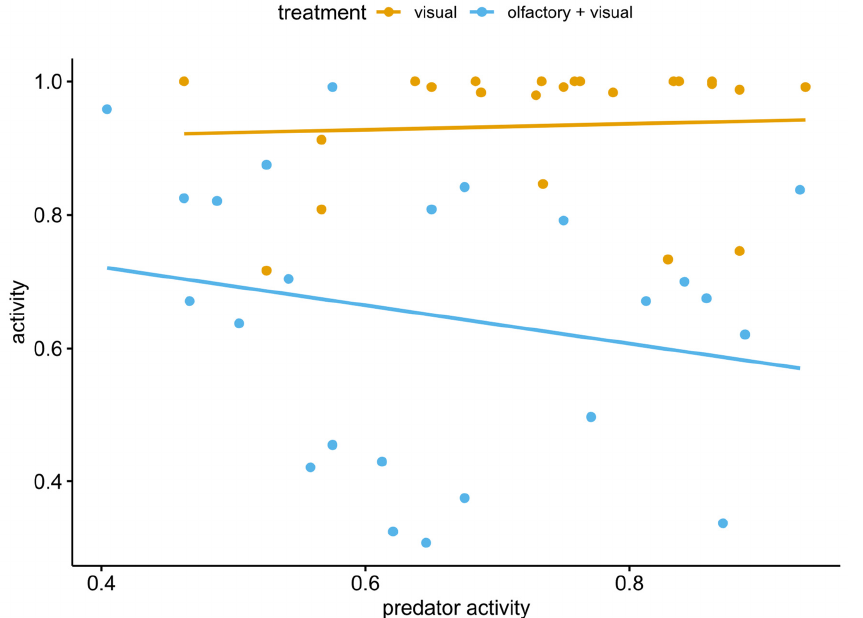
Figure 5. Relationship between tadpole post-stimulus activity and predator activity for both visual and olfactory + visual cue treatments.